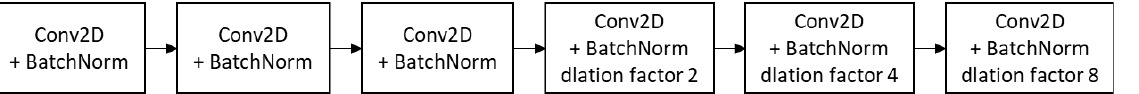
Figure 7. A schematic representation of the fully convolutional 2D network. ReLU activation was used after each block except the last one. The final activation waws softmax. Both input and output are 2D.